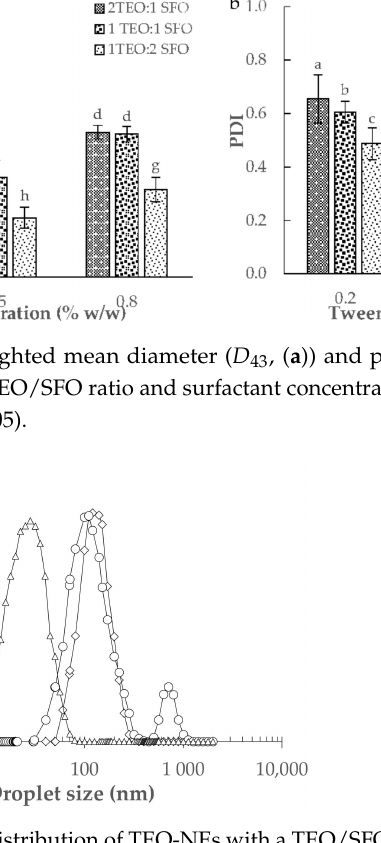
Figure 2. The droplet size distribution of TEO-NEs with a TEO/SFO of 1:2 at tween-80 concentrations of 0.2% (o), ( ∆ ) 0.5%, and ( ♦ ) 0.8% ( w / w